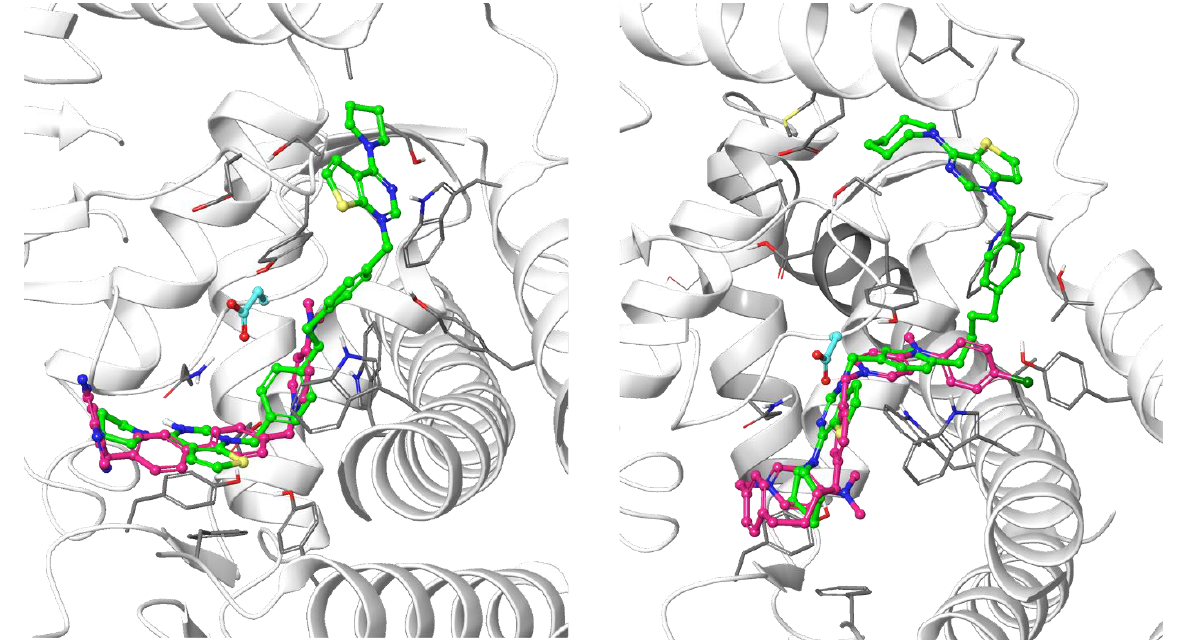
Figure 3. Predicted binding mode of two of the docked compounds into the crystal structures of CK, PDB codes: 4BR3 (left) and 4CG8 (right). The protein is shown as white ribbons; the respective co-crystalized ligands are depicted in magenta stick-and-balls, while the docked compounds ( Fg-15 on the left and Fa-29 on the right) are shown as green stick-and-balls. For reference, Asp306 is shown in cyan.